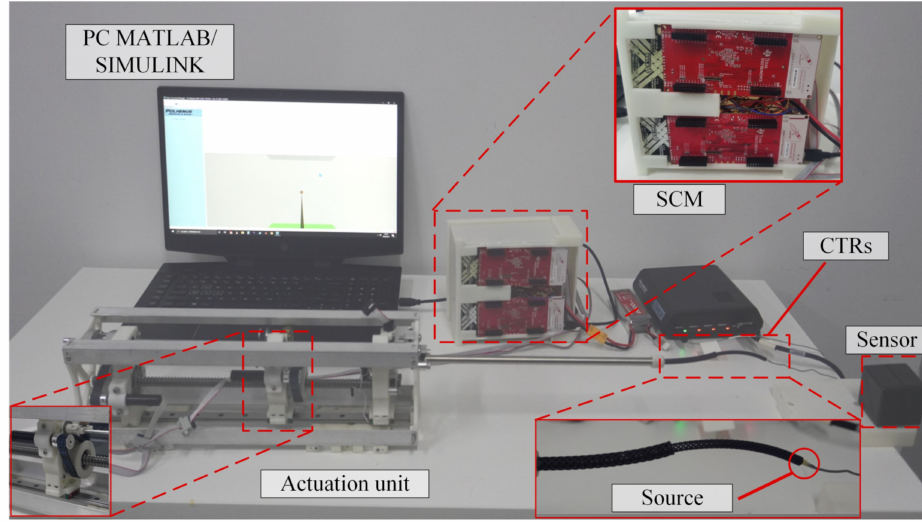
Figure 5. Experimental platform.